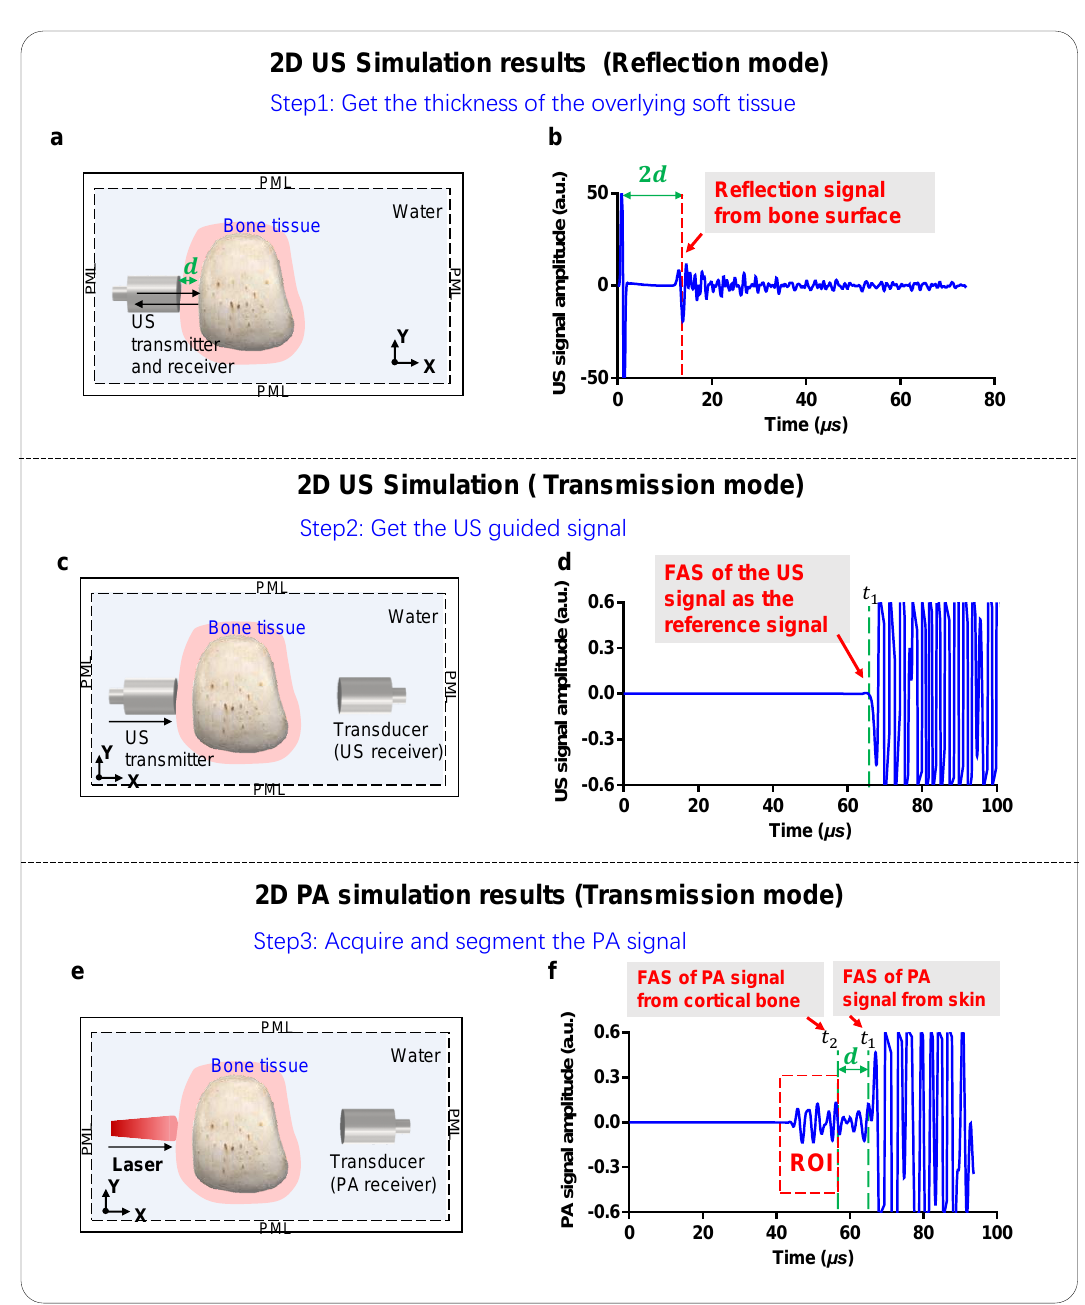
Figure 5. Simulation results of the US and PA signals generated by bone. The bone in the figure is aligned at the position where the signal originated. ( a ) Setup of the US reflection mode simulation; d is the distance between the transducer and bone surface, which can be considered as the thickness of the overlying soft tissue. The transducer placed at the left side of the bone is used as both the US transmitter and receiver. ( b ) Simulation results of the US reflection signal received by the ultrasound transducer in the reflection mode. ( c ) Setup of the 2D numerical simulation for the US transmission mode. ( d ) Simulation results of US signal received by the ultrasound transducer in the transmission mode. t 1 is the time of the FAS of the US signal, which is the US guidance signal. ( e ) Setup of the 2D numerical simulation for the PA transmission mode. ( f ) Simulation results of PA signal received by the ultrasound transducer in the transmission mode. t 2 = t 1 − d / c. The dashed box indicates the region of interest (ROI). FAS: first arriving signal.